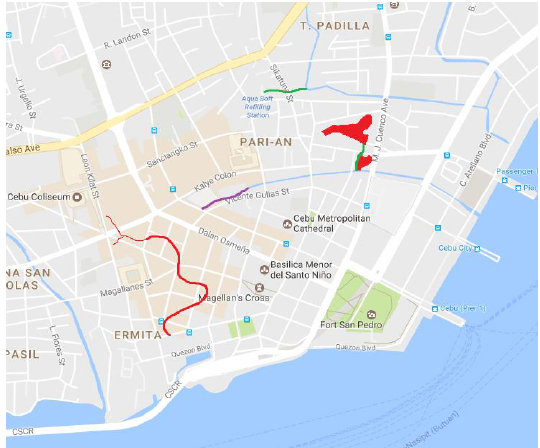
Figure 19. Red - lost bodies of waters in Cebu City. Green - still existing estuaries. Violet - Estuaries that have gone underground.